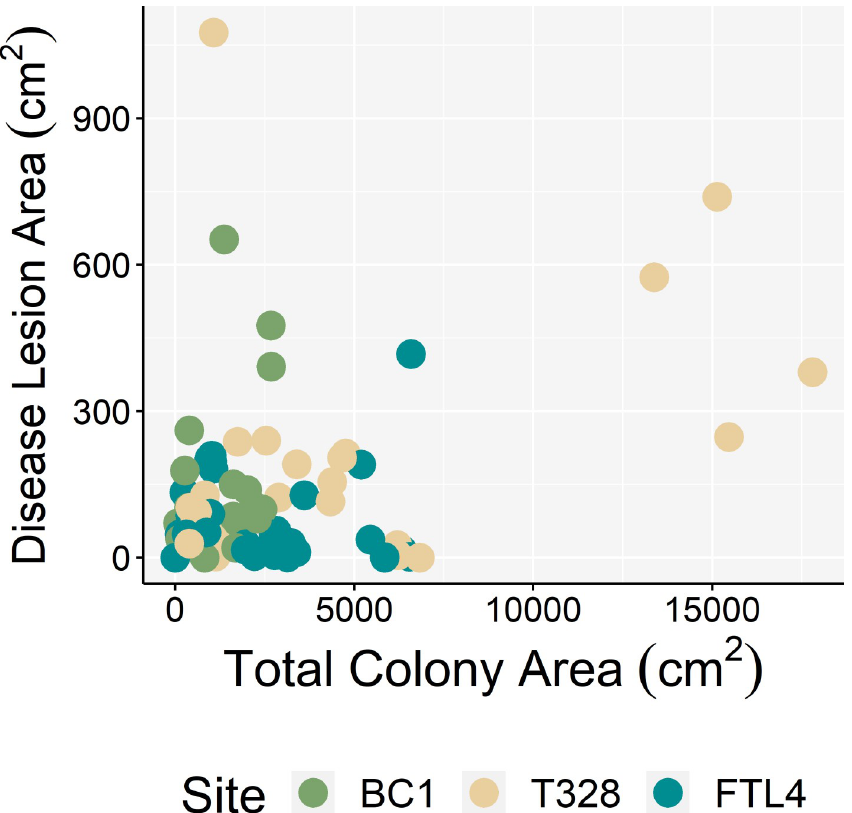
Fig 6. Correlations between total colony area and disease lesion area. Spearman’s rank correlation between disease lesion area (cm 2 ) and total colony area (cm 2 ) for fate-tracked M . cavernosa colonies ( n = 24).